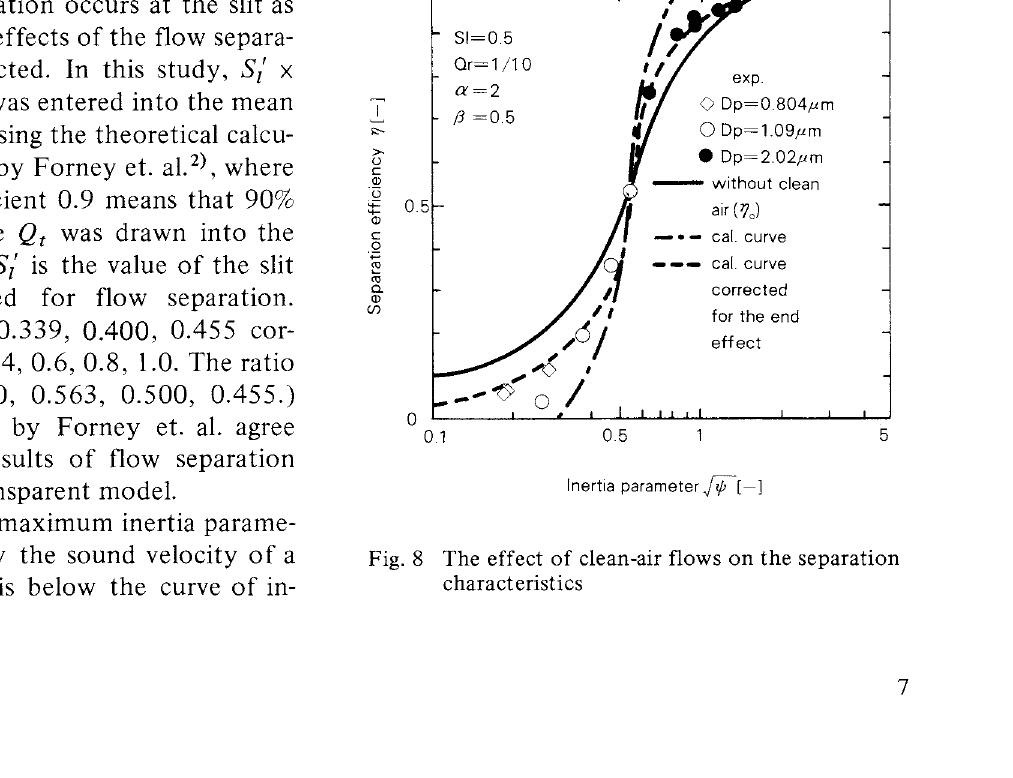
Fig. 8 The effect of clean-air flows on the separation